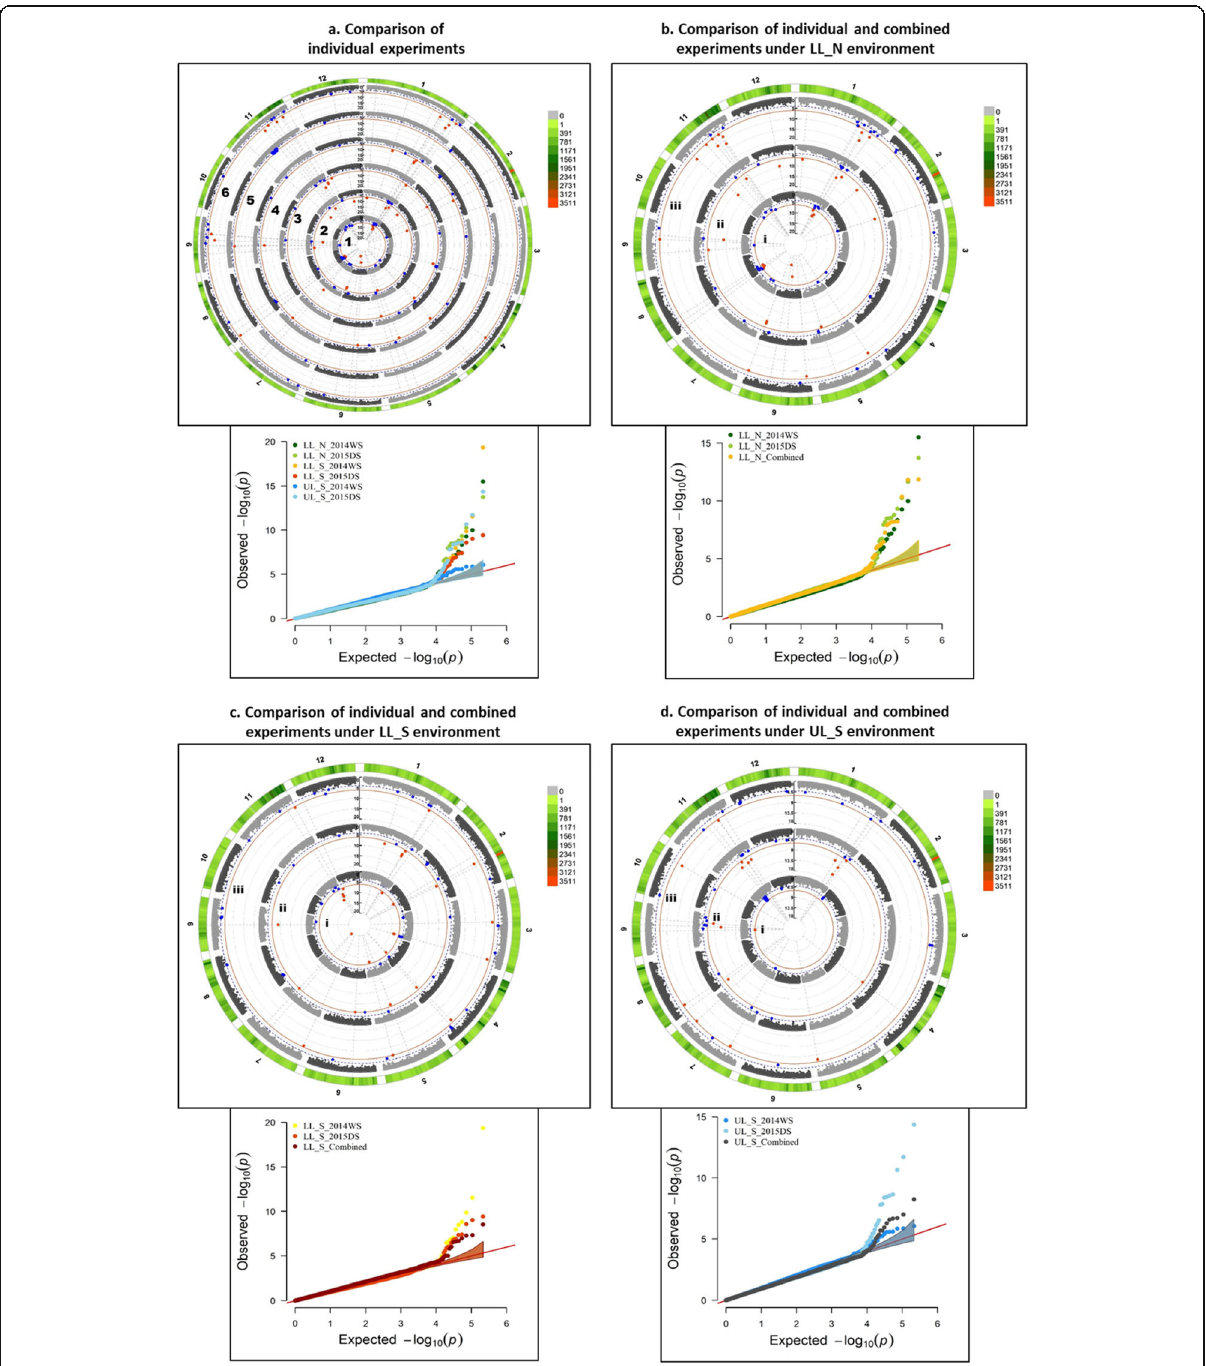
Fig. 5 Circular manhattan plot and qq plot for Plant height (PH)- a . each of the six experiments (from centre of the plot- 1. lowland non-stress 2014WS (LL_N_WS); 2. lowland non-stress 2015DS (LL_N_DS); 3. lowland stress 2014WS (LL_S_WS); 4. lowland stress 2015DS (LL_S_DS); 5. upland stress 2014(UL_S_WS) and 6. upland stress 2015DS (UL_S_DS) for p -values obtained using Farm-CPU method at two significance thresholds of 1e- 4 (blue) and 1e-6 (red). The outermost ring depicts the SNP distribution in the 215,250 SNP working set. Individual experimental results are compared to the combined analysis for each of the three environments- b. LL_N, c . LL_S and d. UL_S, to detect seasonal variation between WS and DS, from centre of the plot-i. WS, ii. DS and iii. Combined